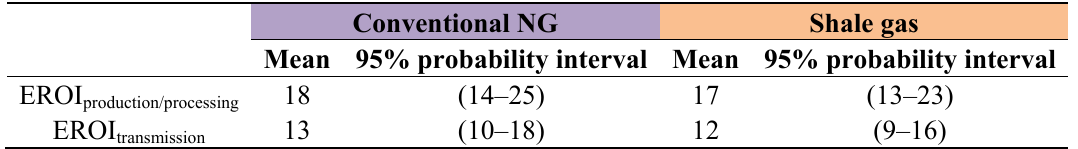
Table 5. Comparison of statistical results of EROIs derived from Monte Carlo simulation between conventional NG and shale gas. The 95% probability interval is shown in parentheses.